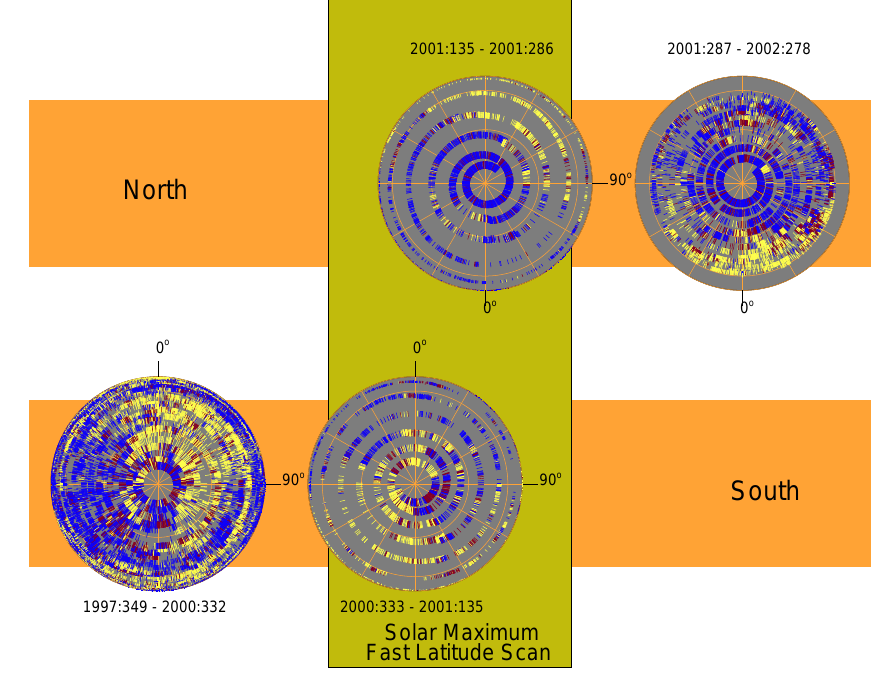
Fig. 4. The polarity data presented in the final two and a half panels of Fig. 2, in the same format as Fig.